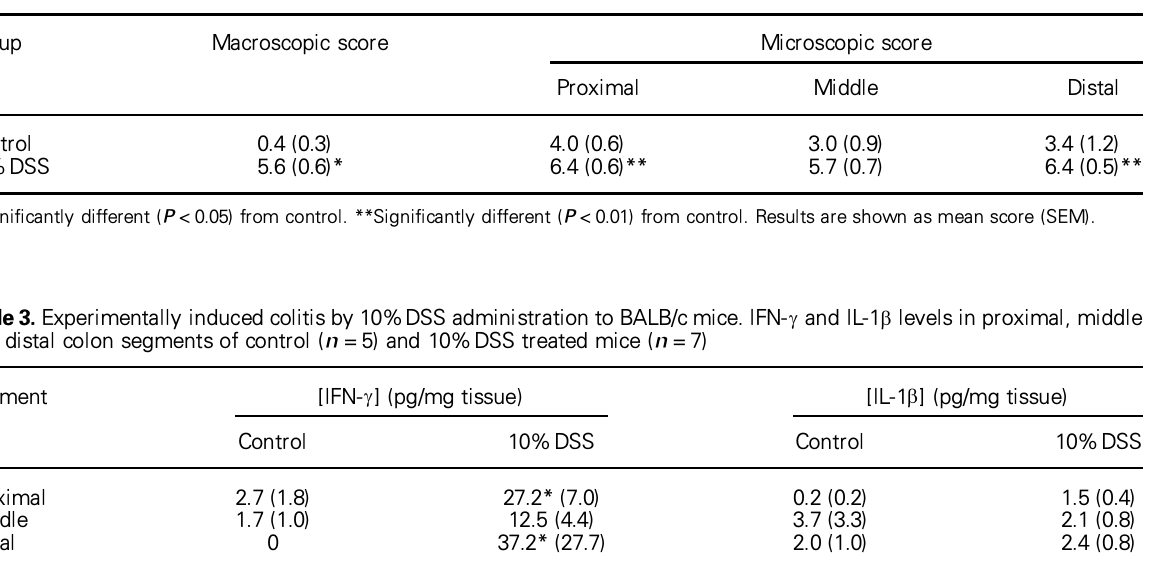
Table 2. Experimentally induced colitis by 10% DSS administration to BALB/c mice. The degree of inflammation determined by macroscopic scoring and histology for proximal, middle and distal colon segments of control ( n = 5) and 10% DSS treated mice ( n = 7)